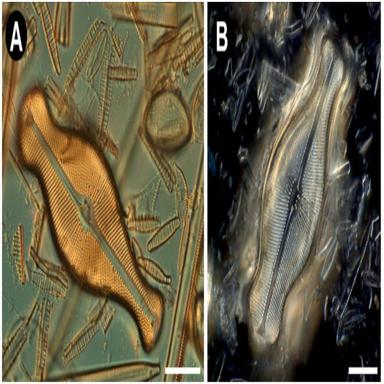
Light microscopy images of Didymosphenia geminata frustule in (A) bright field, (B) dark field. Scale bars: 20 µm.